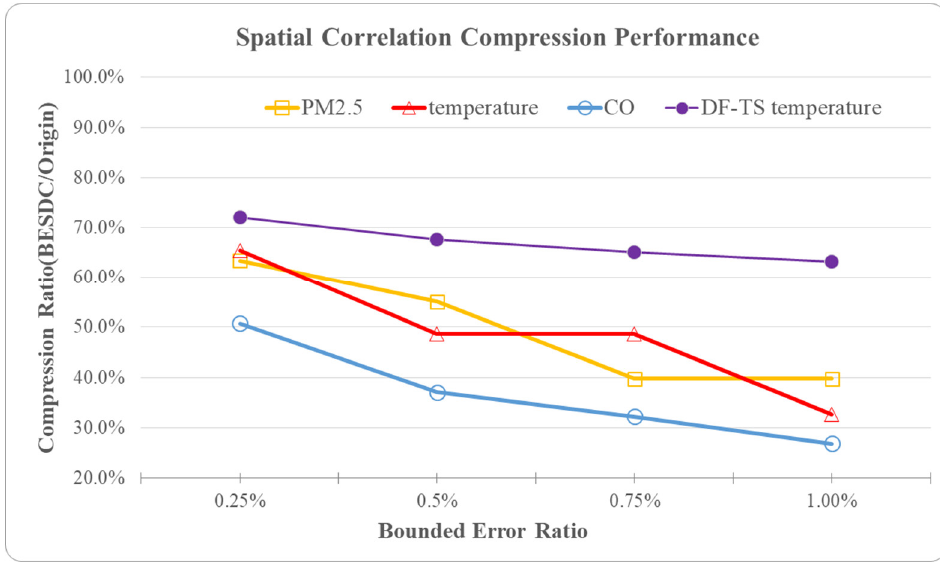
Figure 8. Data compression ratio in SN with neighboring EDs by spatial correlation compression.